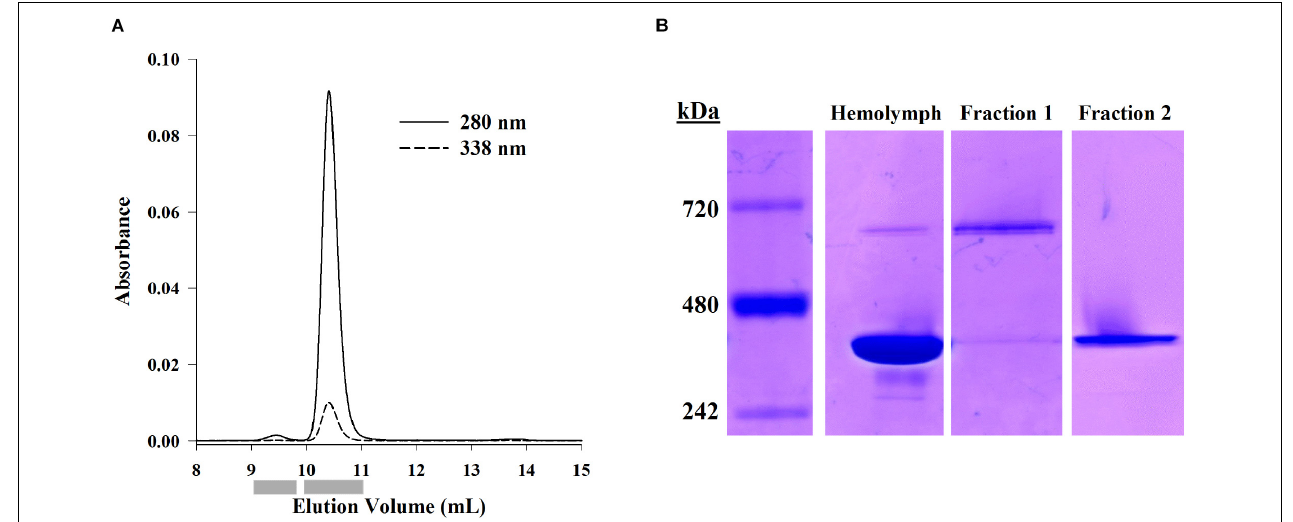
FIGURE 1 | Separation of hemocyanin oligomer forms using SE-HPLC or native PAGE. (A) Representative SE-HPLC chromatogram (OD 280 and OD 338 ) of L. vannamei hemolymph proteins showing two peaks at 9.5 mL (dodecamer) and 10.4 mL (hexamer). Gray bars indicate fraction collection windows. (B) Proteins from hemolymph, dodecamer fractions, and hexamer fractions separated by native PAGE (Bis-Tris 3–12%) and visualized with Coomassie-R250 staining show hexameric (403 kDa) and dodecameric (673 kDa) hemocyanin in hemolymph. The hexamer fraction is exclusively hexamer while the dodecamer fraction shows some hexamer as well.